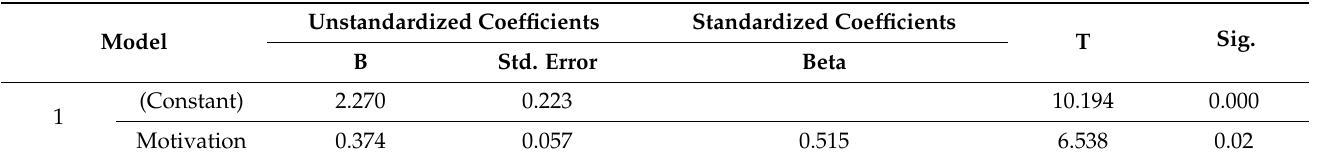
Table 4. Impact of motivational factors on job satisfaction level.